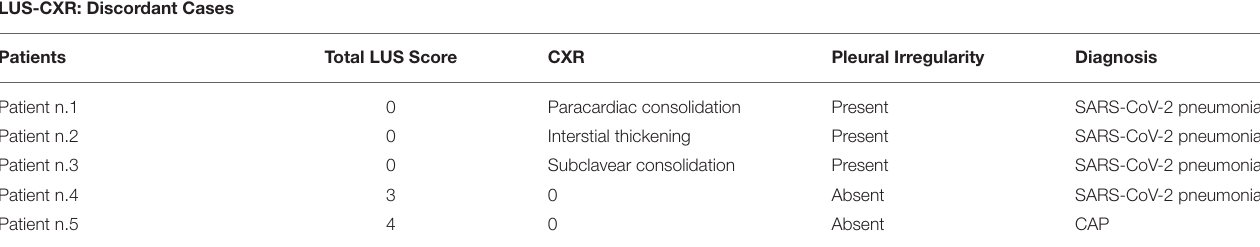
TABLE 4 | Comparison of LUS and CXR results in the discordant cases. LUS-CXR: Discordant